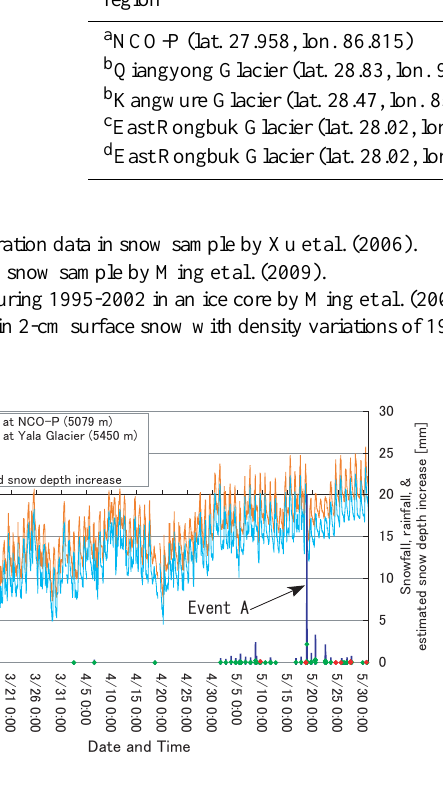
Fig. 4. Air temperature variations at NCO-P site and over Yala Glacier, together with the amount of snowfall and rainfall, and esti- mated snow depth increases over Yala Glacier. The air temperature over Yala Glacier was estimated with a temperature lapse rate of 6.5Kkm − 1 . If air temperature was below 0degree in Celsius, pre- cipitation was considered to be snow. The snow depth increases were calculated with a typical fresh snow density of 110kgm − 3 . Fig. 5. Difference between precipitation ( P ) and estimated evapo-